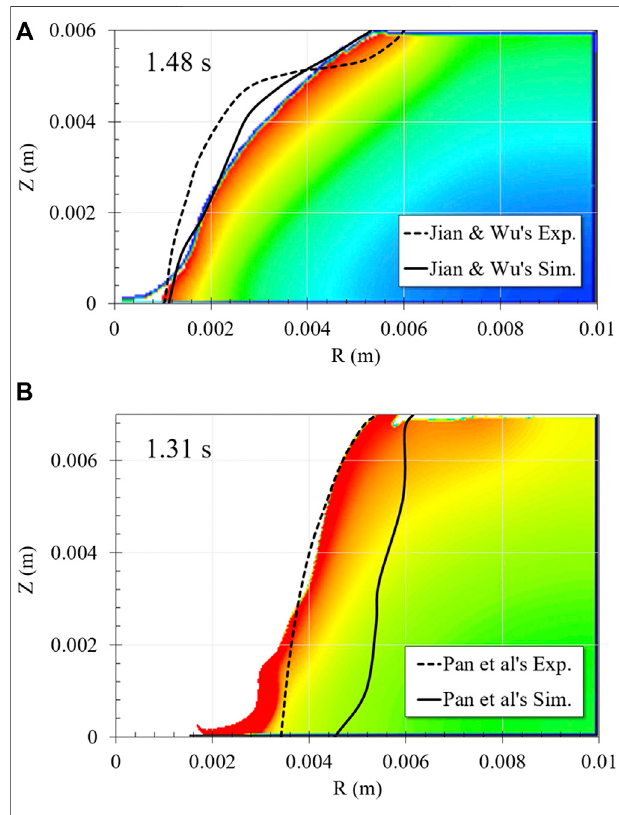
FIGURE 5 | Validation of workpiece melting behavior. (A) Use steel as the workpiece. (B) Use aluminum as the